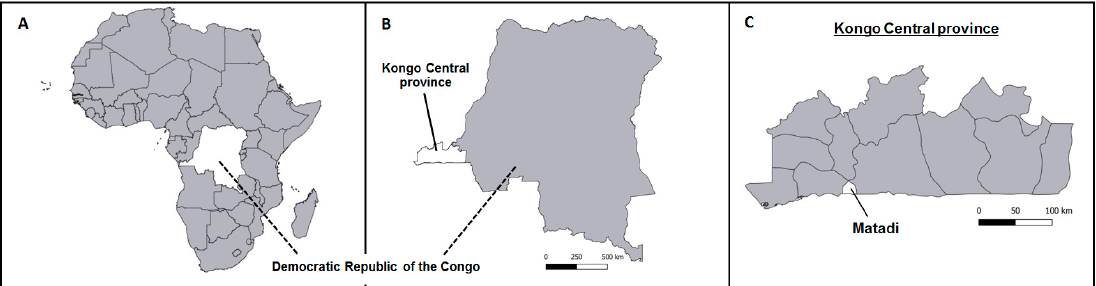
Figure 1. Maps indicating the Democratic Republic of the Congo ( A ) and the Kongo Central province ( B ) with the study site Matadi ( C ).